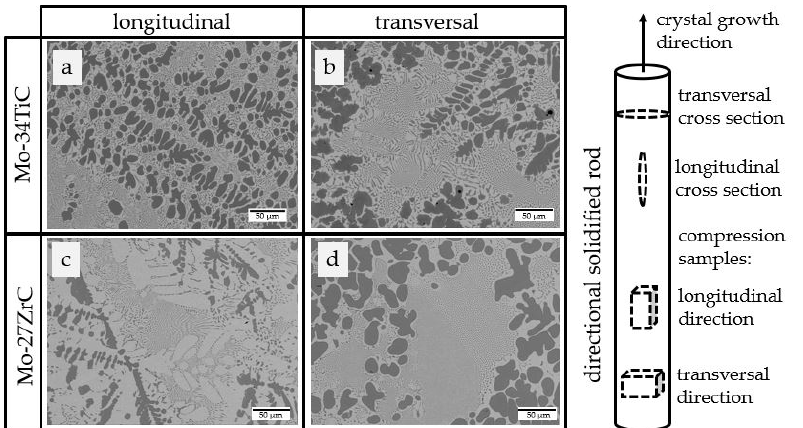
Figure 1. SEM-BSE images of Mo-34TiC and Mo-27ZrC in longitudinal and transversal section, representing eutectic colonies as well as dendritic regions. The Mo solid solution is the bright grey phase, whereas TiC and ZrC are depicted as the dark grey phases.